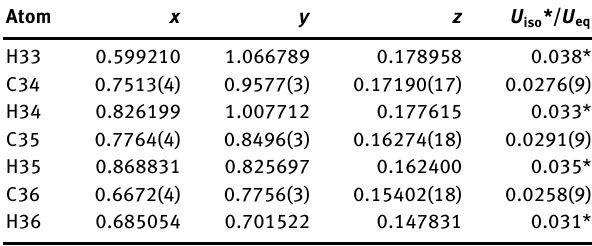
Table 2: Fractional atomic coordinates and isotropic or equivalent isotropic displacement parameters (Å 2